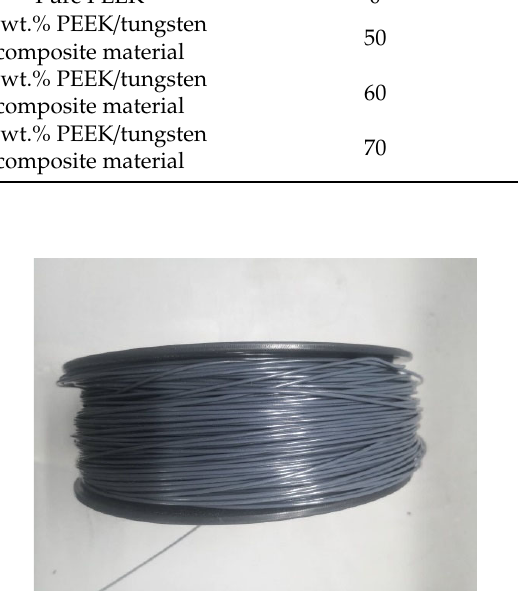
Figure 3. FDM 3D printed special PEEK / tungsten shielding materials.